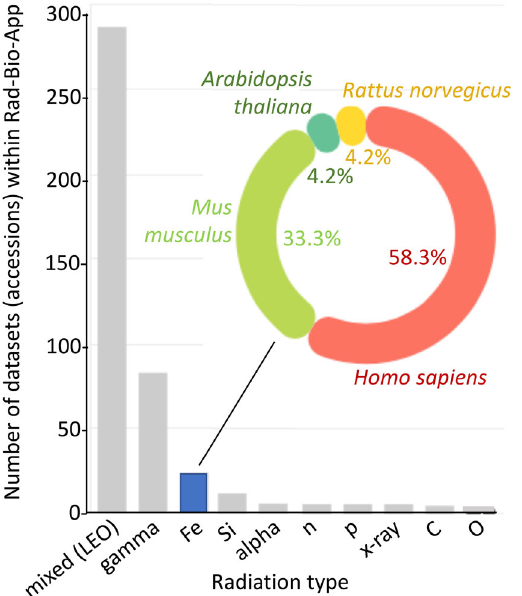
Fig. 3 Datasets for terrestrial experiments exposing biology to different radiation types that are deposited at GeneLab and cross- referenced within the Rad-Bio-App. Shown inset is the distribution of species for the Fe datasets. Mixed LEO represents the varied array of space fl ight data. Output extracted from elements of Rad-Bio- App ’ s graphical